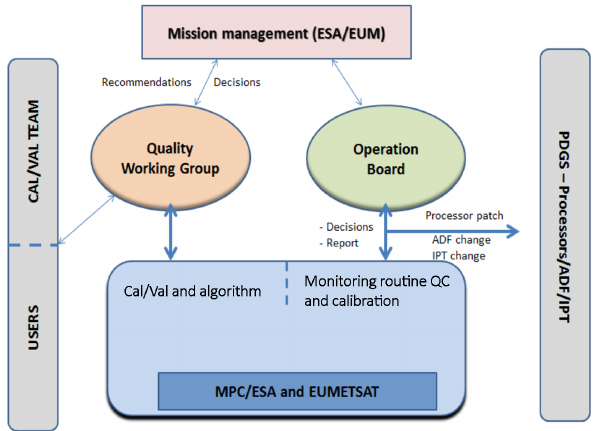
Figure 5. Schematic overview of the joint ESA and EUMETSAT Sentinel-3 Mission Performance Framework. An operational board deals with the daily operations and the resolution of anomalies. On the left side (in grey) there are the users and the user-based Sentinel- 3 Validation Team (see Sect. 3.4) interfacing with the quality work- ing groups (see Sect. 3.2). At the bottom are the core mission per- formance activities of the MPC (see Sect. 3.3) and of the EUMET- SAT Marine Centre (Sect. 3.5). Changes in data products services are generated by updates and patches of the data processors of the instrument parameter tables (IPTs) and of the auxiliary data files (ADFs) in the